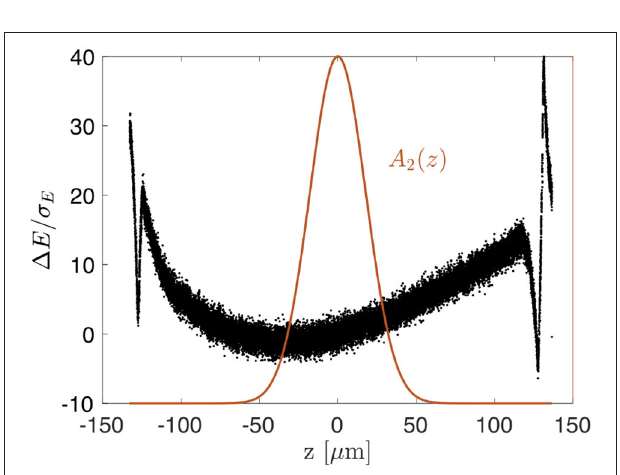
FIGURE 3 | Transform-limited bandwidth σ k as a function of laser pulse E length σ L from Equation (15). Because of harmonic compression, the laser pulse length needs to increase slightly with increasing harmonic number to maintain a fixed bandwidth.